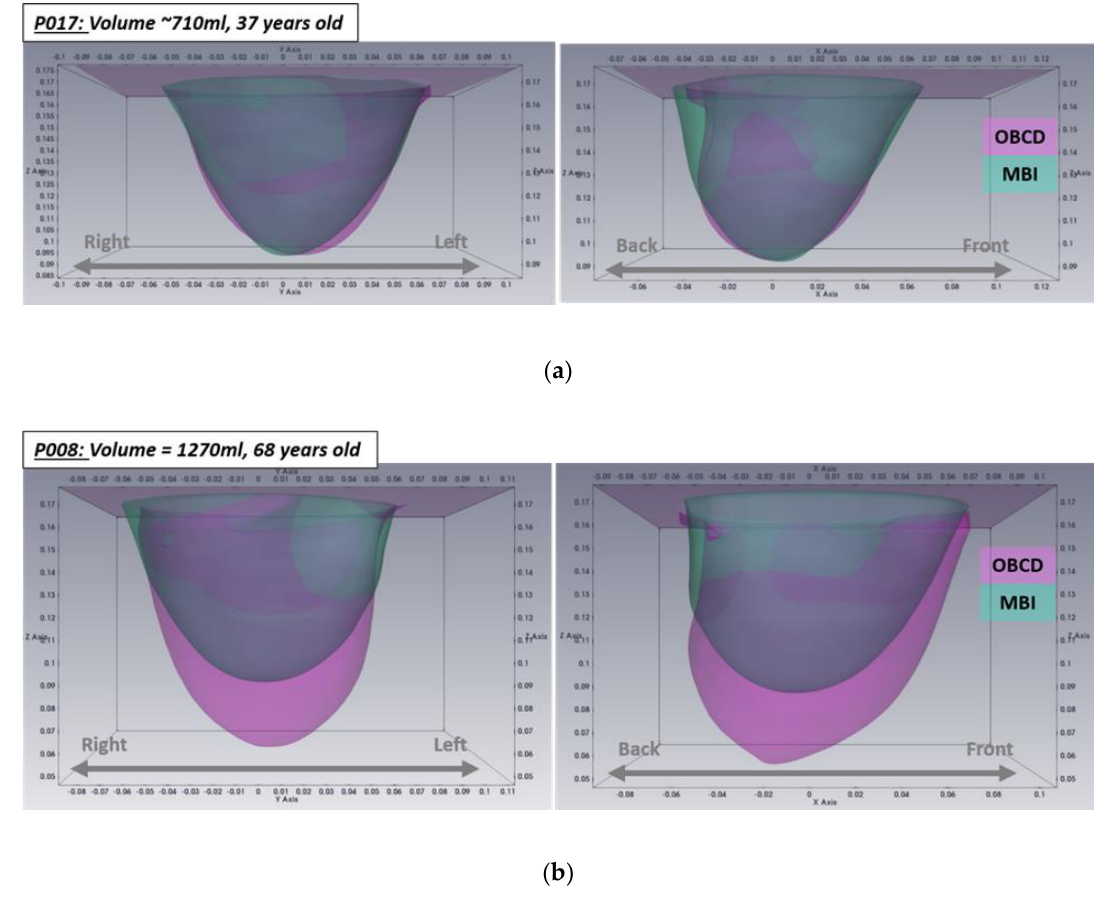
Figure 36. Illustration of the expected level of breast deformation due to immersion in the transition liquid of the Wavelia MBI scanner: ( a ) Patient 017: not significantly deformed breast, when immersed in the transition liquid of the Wavelia MBI subsystem; ( b ) Patient 008: significantly deformed breast, when immersed in the transition liquid of the Wavelia MBI subsystem.